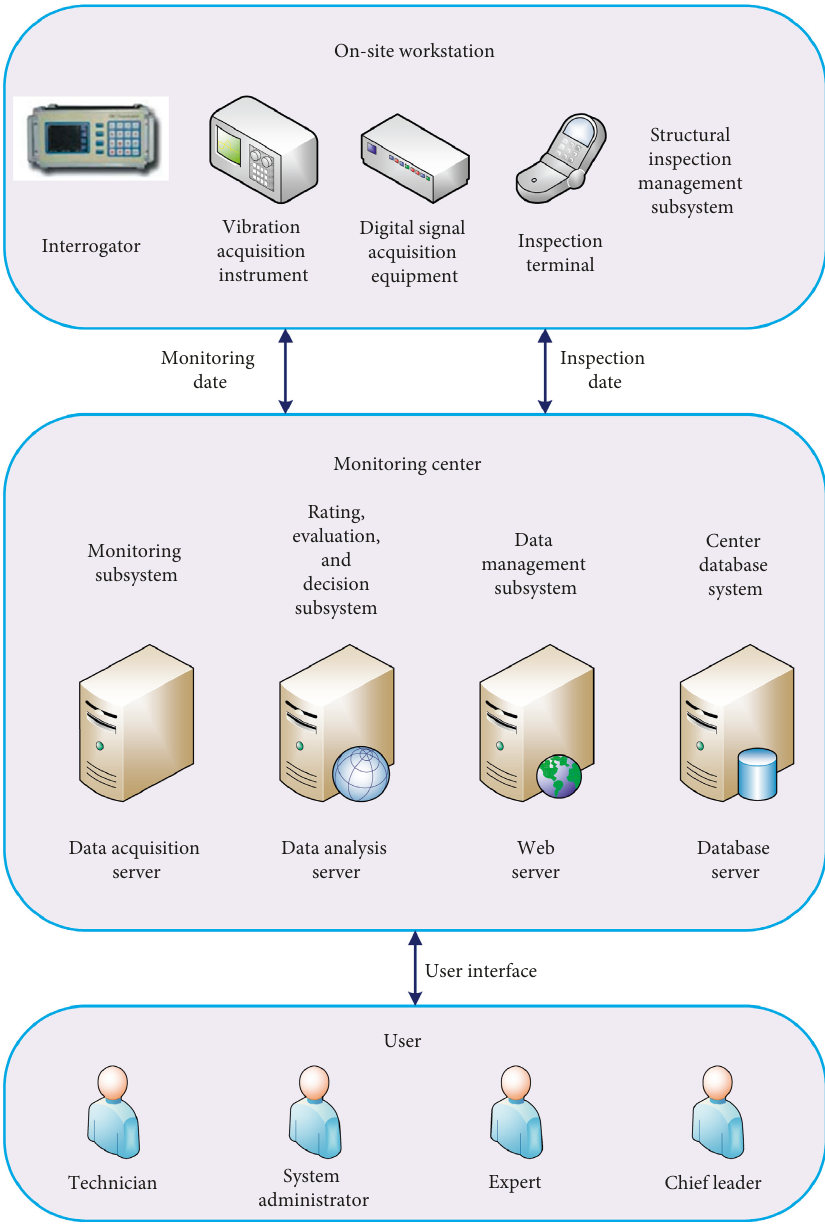
Figure 6: Physical deployment diagram of the